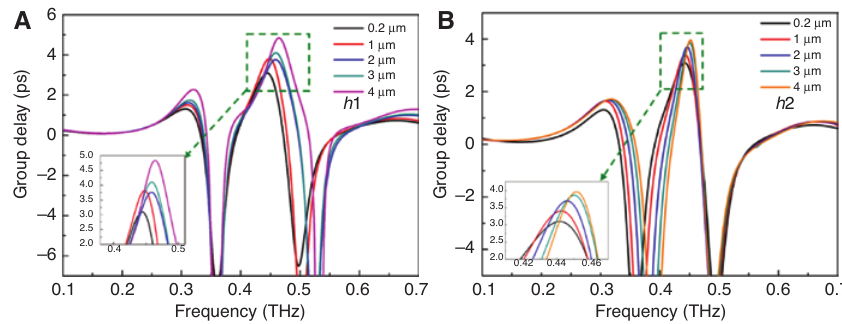
Figure 3: Group delay of the EIT meta-surface with the increase in the height of the IRR (A) and OSRR (B) in the range 0.2–4 μ